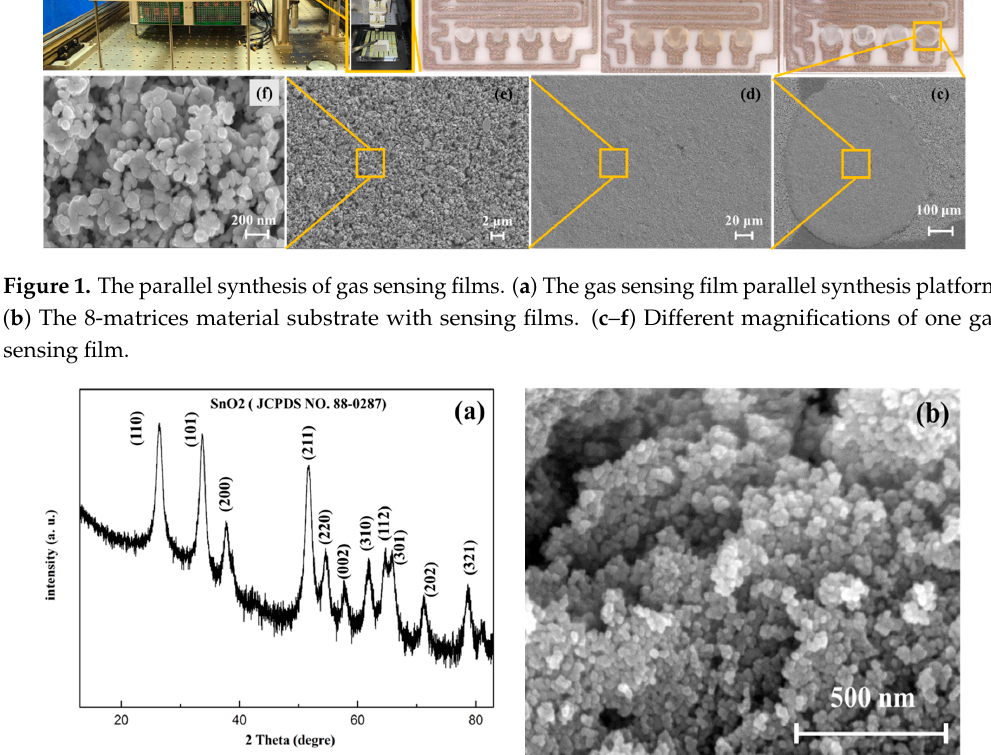
Figure 2. The X-ray diffraction (XRD) and scanning electron microscopy (SEM) images of the raw material. ( a ) X-ray diffraction pattern of SnO 2 nanoparticles. ( b ) SEM image of SnO 2